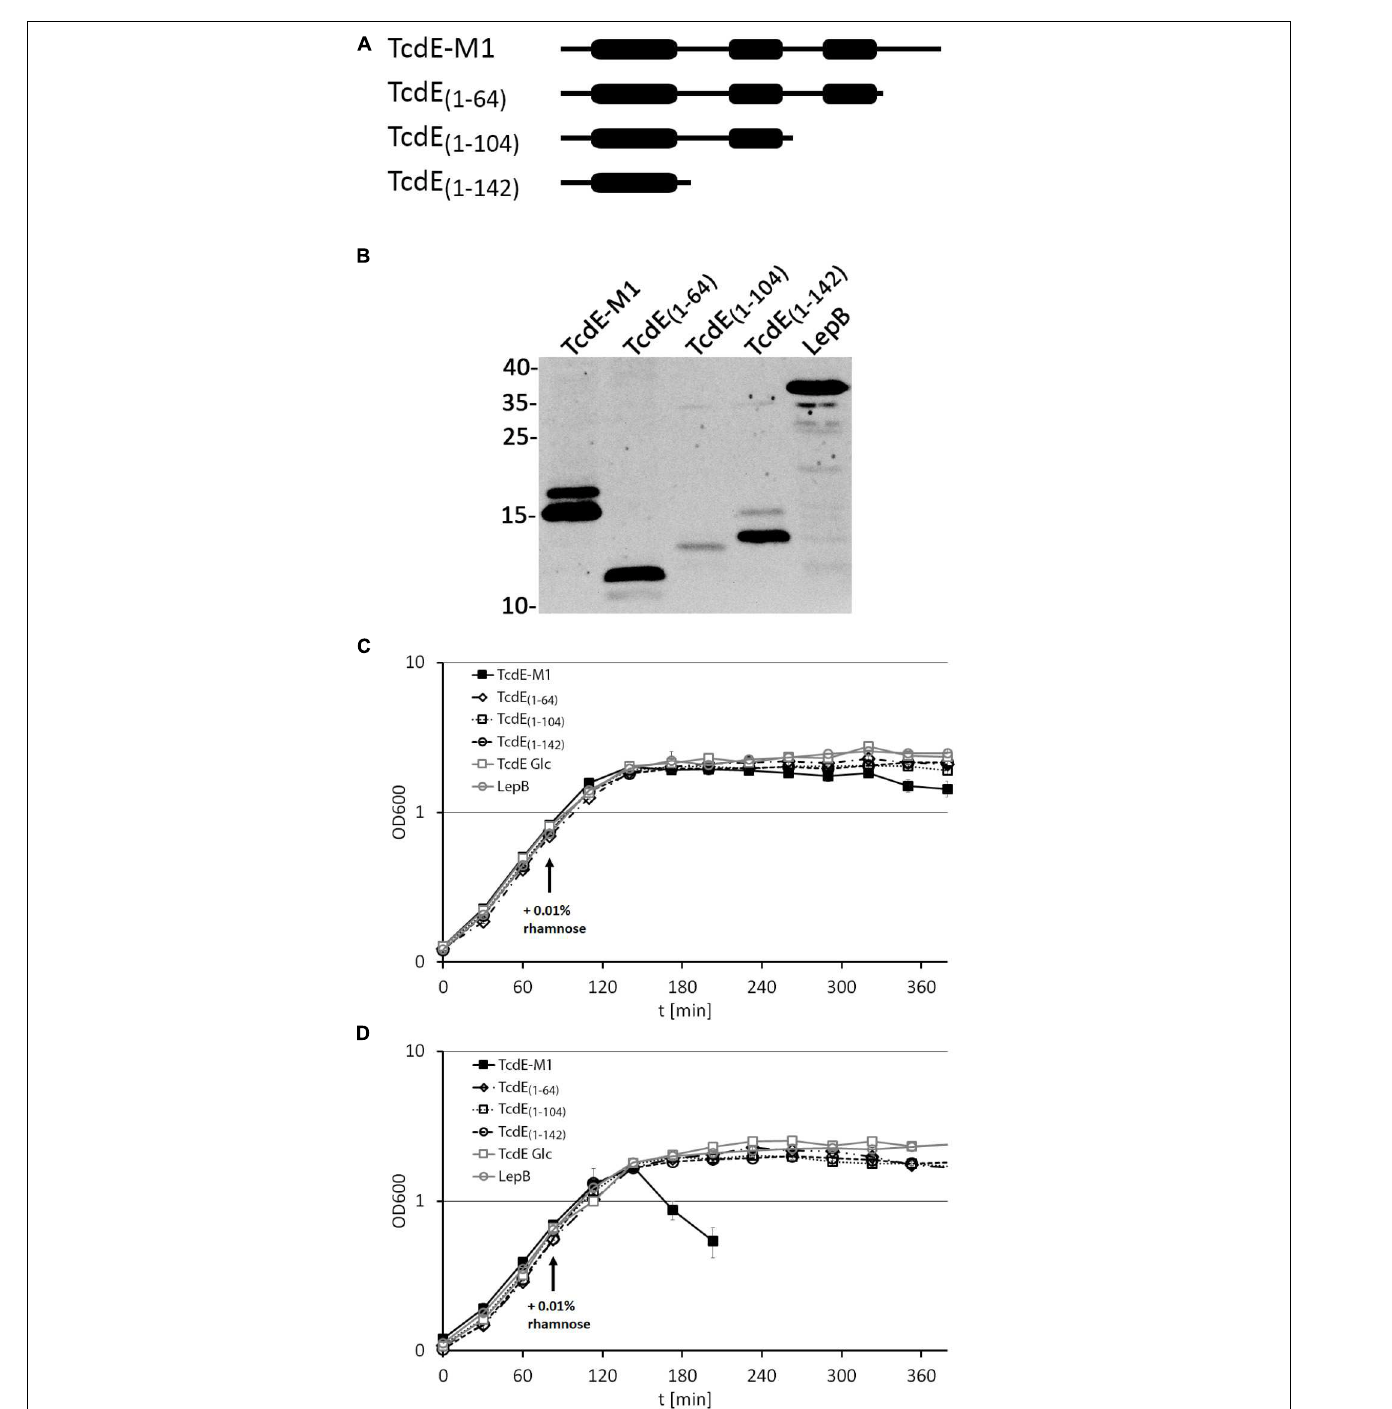
FIGURE 3 | C-terminal truncation abolishes the lytic effect of TcdE. (A) Scheme of the analyzed constructs. The thick regions represent potential trans -membrane domains. (B) Western blot analysis of the constructs produced by the E. coli strains ER2566 pBW- tcdE-M1 -H6, pBW- tcdE ( 1 − 64 ) -H6, pBW- tcdE ( 1 − 104 ) -H6, pBW- tcdE ( 1 − 142 ) -H6, and pBW- lepB -H6. Western blot detection using His-tag antibodies and ECL reaction. Molecular weight markers (in kDa) are indicated on the left. The unrelated membrane protein LepB was used as negative control. (C) Effect of the indicated constructs on growth. “Glc” refers to a culture in which rhamnose-dependent expression of the full-length tcdE construct (TcdE-M1) was suppressed by glucose in the medium. (D) The same experiment as in (C) but with strains producing constitutively LysS from pLysS. Note that only the full-length TcdE-M1 construct is capable of mediating lysis, indicating LysS transport into the